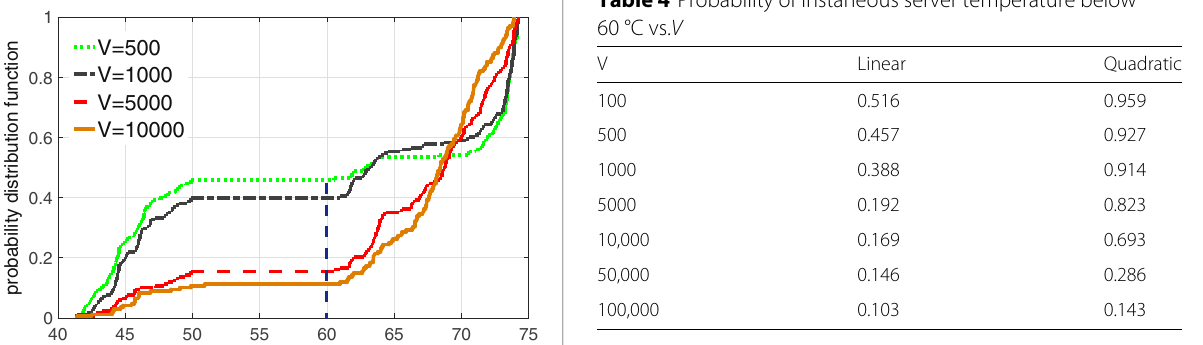
Table 4 Probability of instaneous server temperature